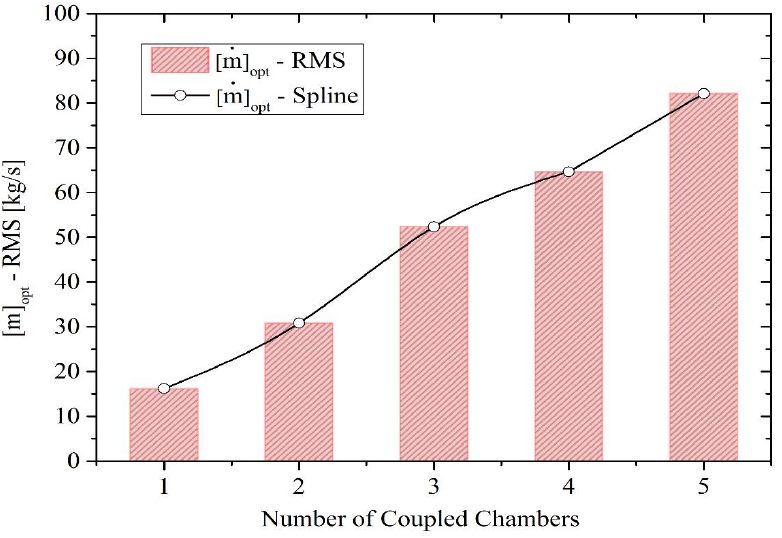
Figure 14. Mass flow rate from the highest performing cases.